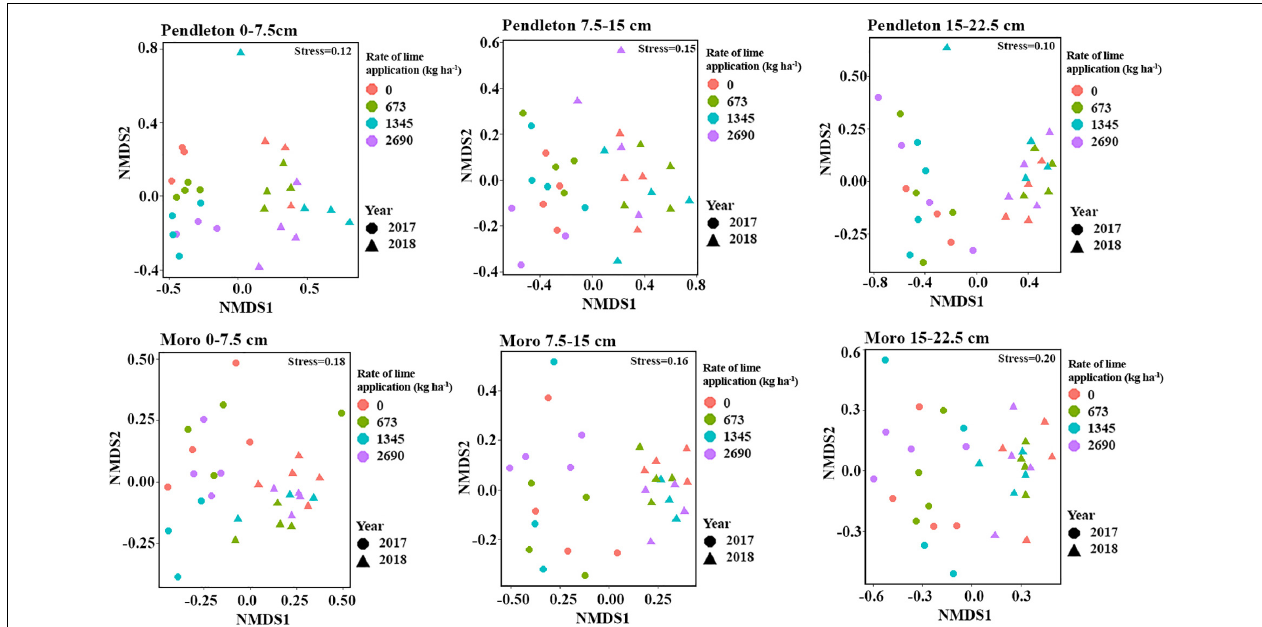
FIGURE 4 | Non-metric multidimensional scaling (NMDS) of fungal community within locations and soil depth (Bray-Curtis distances). Symbols represent sample time after liming (year), and colors represent rate of lime application (kg ha − 1 ).